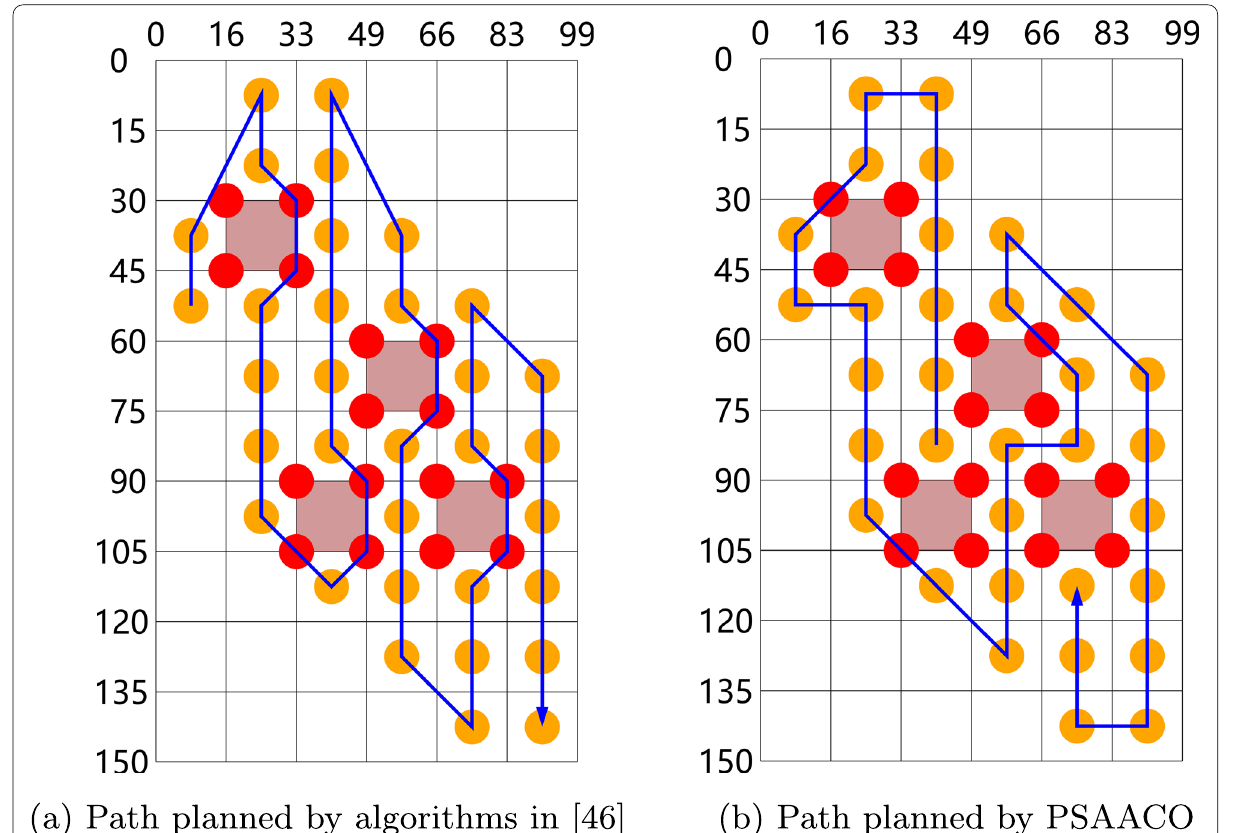
Fig. 10 Paths planned on area 1 by the algorithms in [46] and